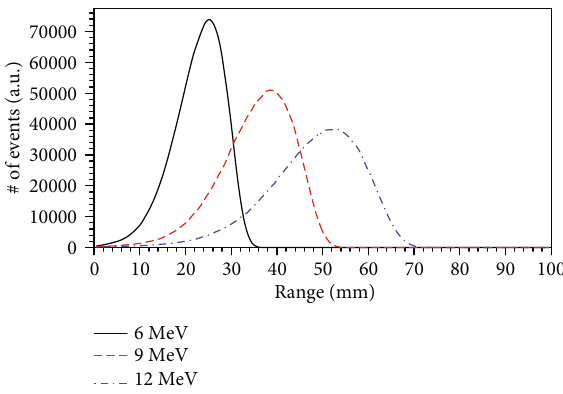
Figure 6: A comparison of range using various electron beam energies of 6, 9, and 12 MeV. The practical range ð R p Þ was measured for each